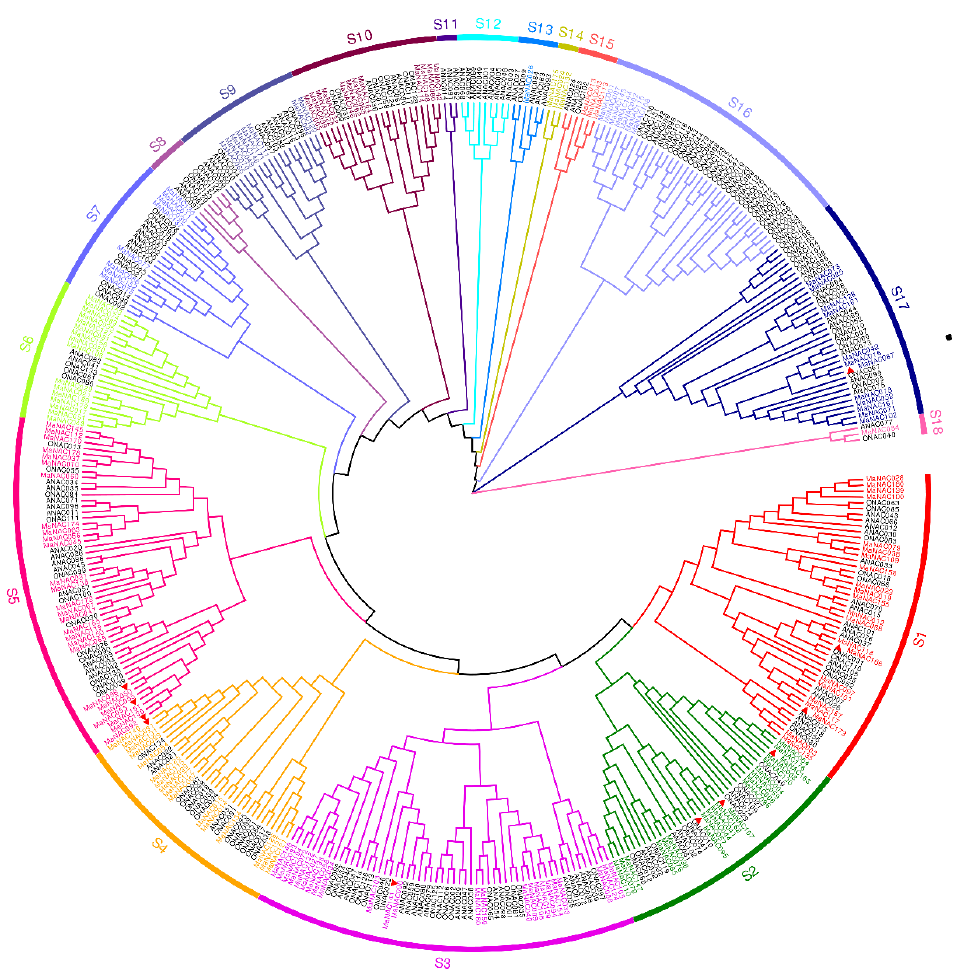
Figure 3. Phylogenetic analysis of NAC transcription factors from Arabidopsis, rice, and banana. ClustalW was applied for the alignment of protein sequences. Neighbor-joining method with 1000 bootstrap replicates was utilized to construct the phylogenetic tree in MEG7.0 software. Each NAC subfamily is indicated in a specific color. NAC proteins from banana are denoted in red.